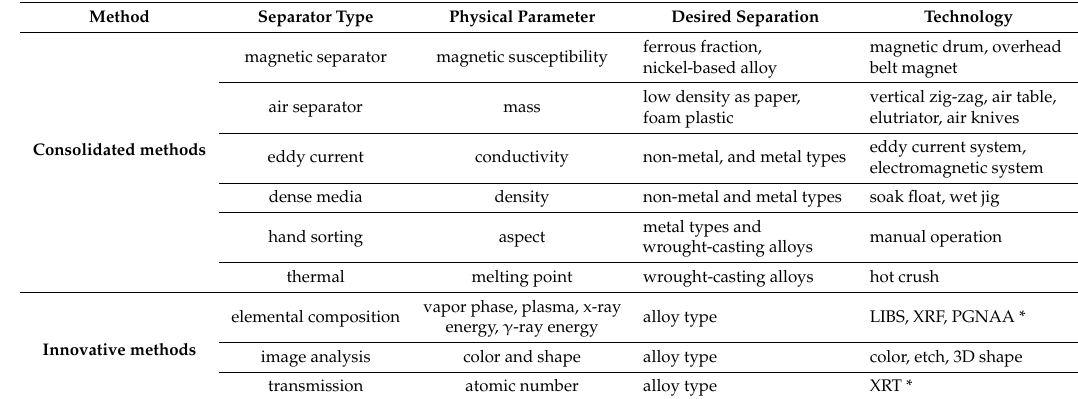
Table 2. Classification of consolidated and innovative sorting methods showing the physical parameter and the desired separation; the developed technologies are also reported for each method.